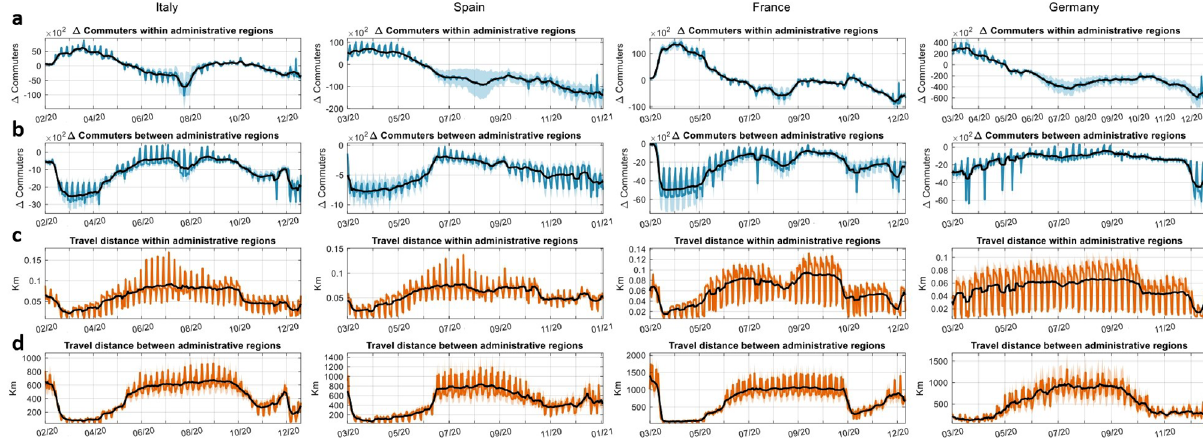
Figure 4. Line diagrams of the commuting patterns dynamics. The line diagram show the evolution of the mobile-phone-based commuting difference ( (cid:31) Commuters ) within ( a ) and between ( b ) administrative regions with respect to baseline and the average travel distance (km) within ( c ) and between ( d ) administrative regions in Italy, Spain, France and Germany. In particular, the mobile-phone-based commuting difference is computed with respect to a baseline value (the average of the three weeks prior to the lockdowns). Colored solid lines represent the real average time series dynamics, black solid lines show the 7-day moving averages, shaded areas indicate the 1-standard deviation bands. Administrative regions are at NUTS3 level (province) for Italy, Spain and France, while for Germany data are available at NUTS2 level